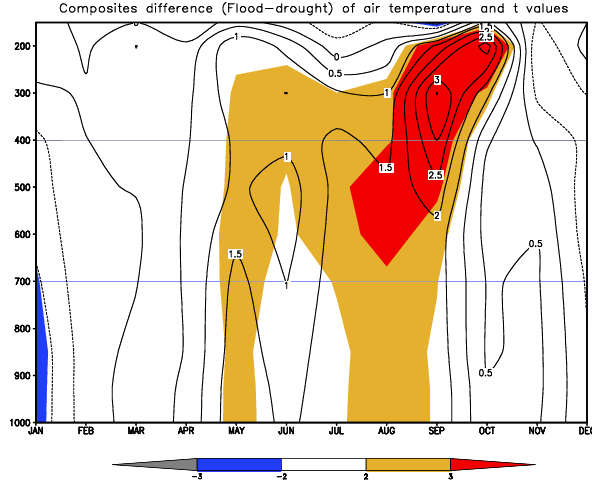
Figure 6. Vertical time variation of monthly composite difference (flood–drought) of air temperature anomalies for the months of Jan- uary to December over region R1 (line contour plot) and 5% sig- nificant level t values are plotted as shaded contour. Table 1. Contingency table for frequency of occurrence of flood, drought and normal rainfall over India corresponding to warm, nor- mal and cold temperatures over region R1. Flood Normal Drought